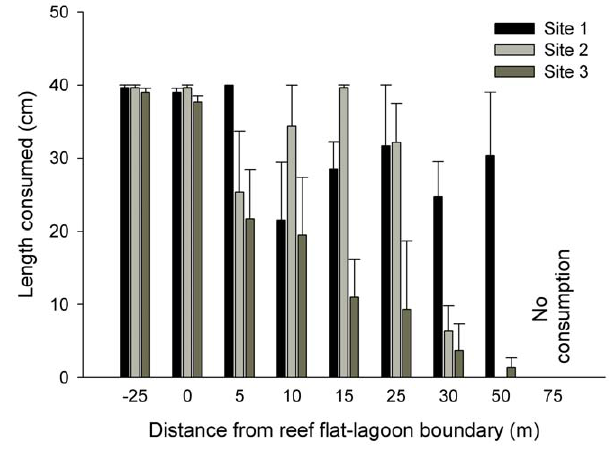
Figure 6. Effect of proximity to reef on consumption of macroalgae. Length of Sargassum myriocystum lateral branches consumed after 48 hours (mean 6 SE) at increasing distances from the reef flat/lagoon boundary in the three experimental sites.